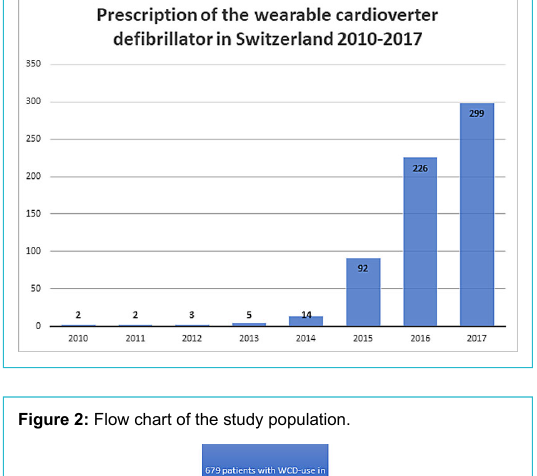
Figure 1: Prescription of the wearable cardioverter defibrillator in Switzerland 2010–2017.